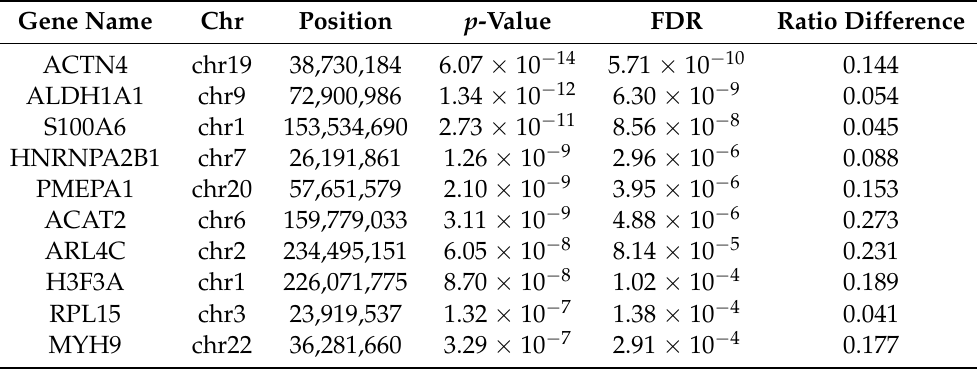
Table 4. Top 10 significant alternative polyadenylation events in the 3 (cid:48) -UTR region (UTR-APA) between A549 mock-treated and SARS-CoV-2 infected cells. The ‘Position’ column refers to the potential cleavage site for the